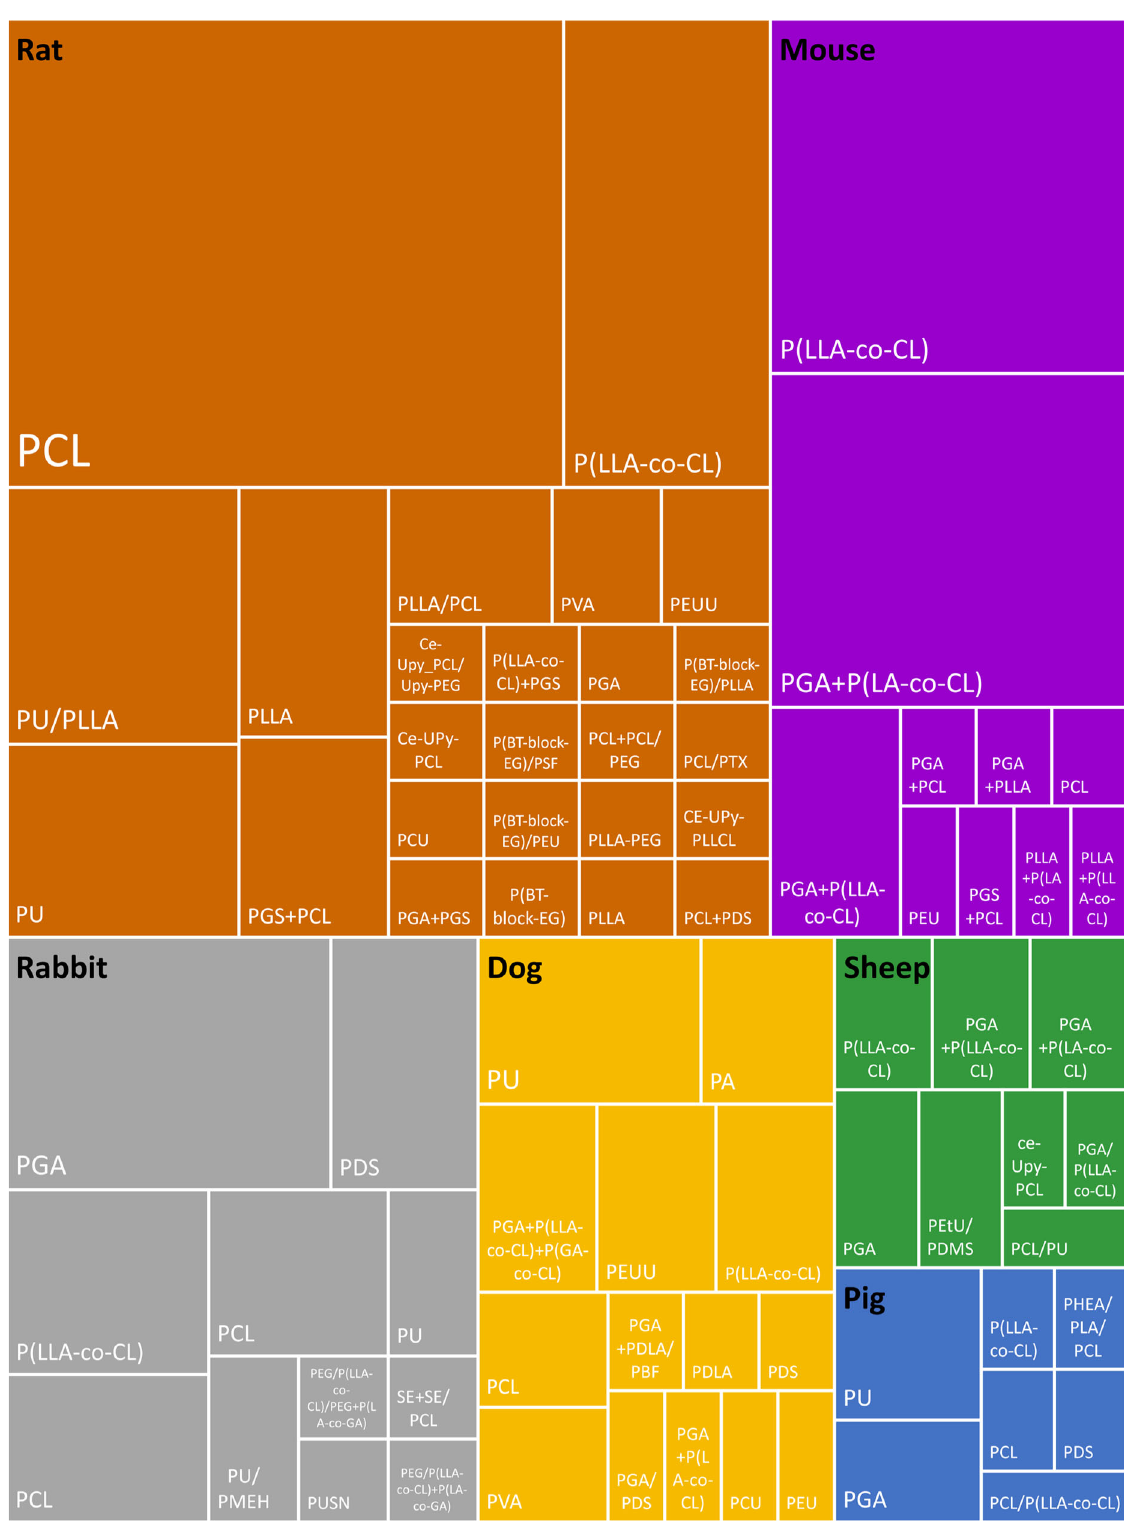
Fig. 6 Mapping of materials used for in situ TE vascular grafts per species. Relative size represents number of studies using the speci fi c material type. Blended materials are separated by /, and different graft layers are separated by + . Abbreviations: PHEA a,b-poly(N-2- hydroxyethyl)-D,L-aspartamide, CE-Upy Chain extended-ureido-pyrimidinone, PTX Paclitaxel, PBF poly(2,3-butylene furmarate), PMEH poly(2- methacryloyloxyethyl phosphorylcholine-co-2-Ethylhexyl methacrylate), PUSN poly(ester urethane)urea with disul fi de and amino group, PetU poly(ether)urethane, P(LA-co-GA) poly(lactid acid-co-glycolic acid), P(LLA-co-CL) poly(L-Lactic-co-caprolactone), P(BT-block-EG) poly(poly- butylene terephthalate-co-polyether glycol), PA polyamide/nylon, PCL polycaprolactone, PCU polycarbonate urethane, PDMS polydimethylsi- loxane, PDS polydioxanone, PDLA poly-D-L-lactic acid, PEU polyesterurethane, PEUU polyesterurethane urea, PEG polyethylene glycol, PGA polyglycolic acid, PGS polyglycerol sebacate, PLLA poly-l-lactic acid, PU polyurethane, PVA polyvinyl alcohol, SE synthetic elastin. Published in partnership with the Australian Regenerative Medicine Institute npj Regenerative Medicine (2022)